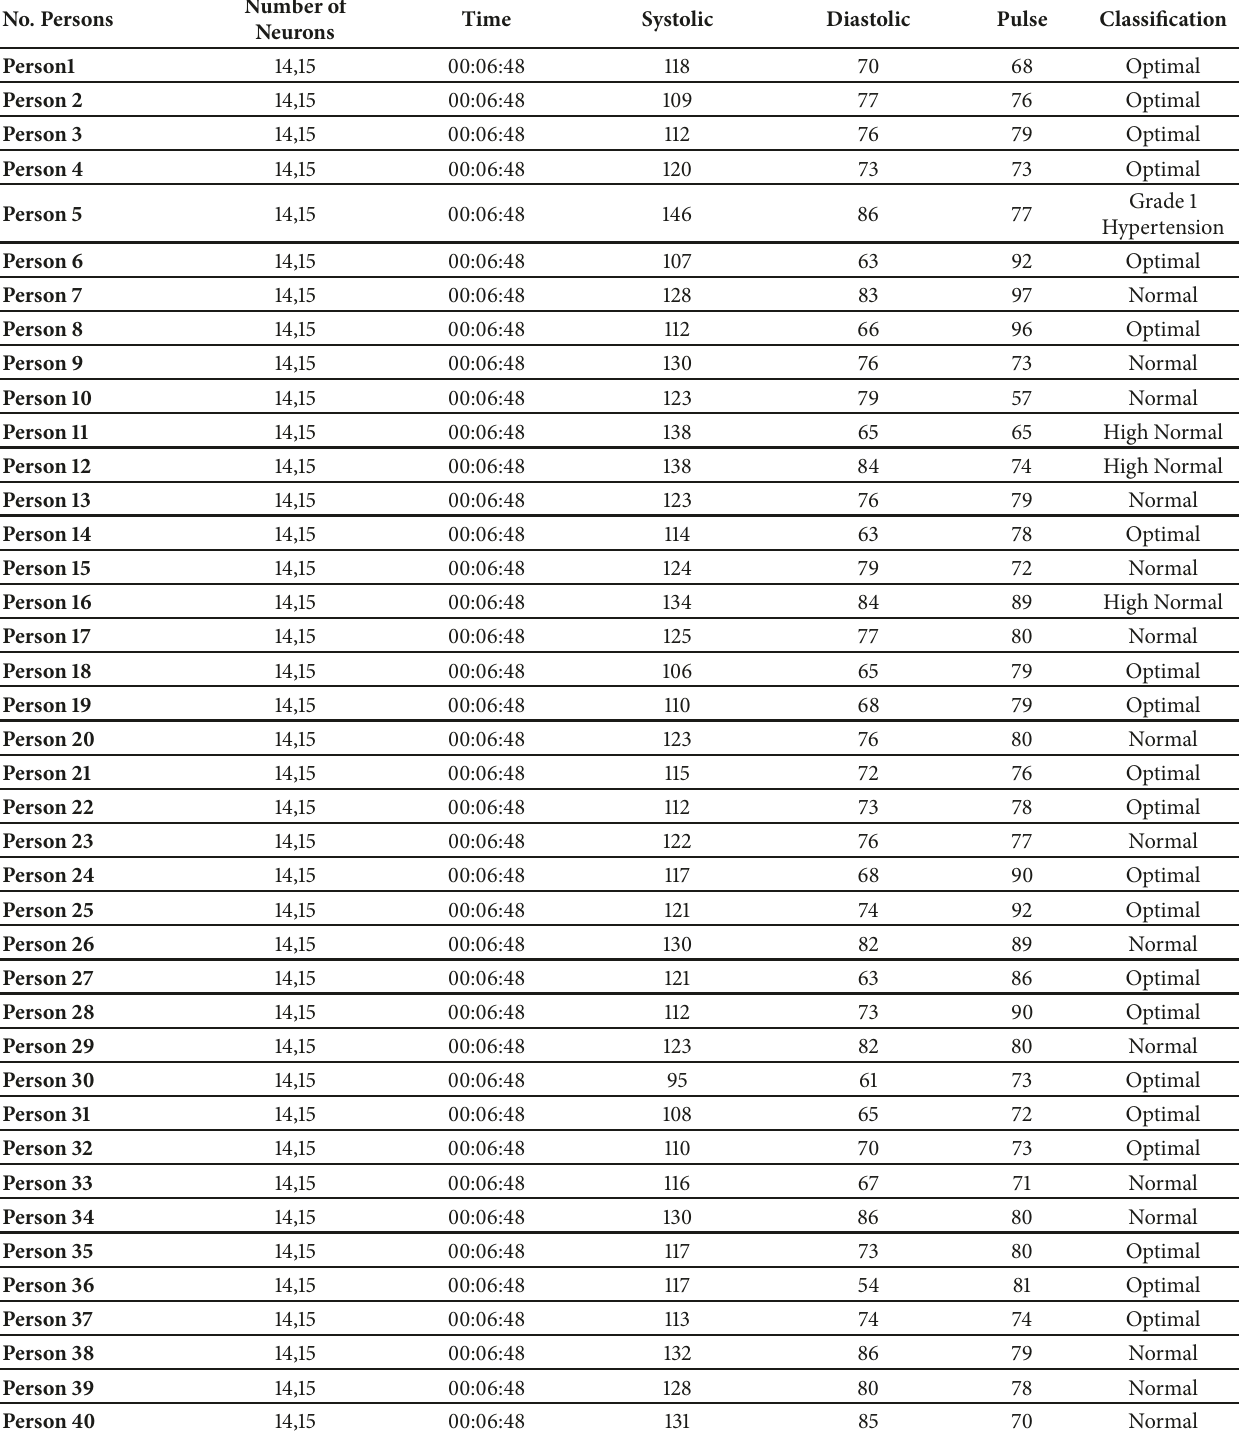
Table 3: Classification for MNN with train method